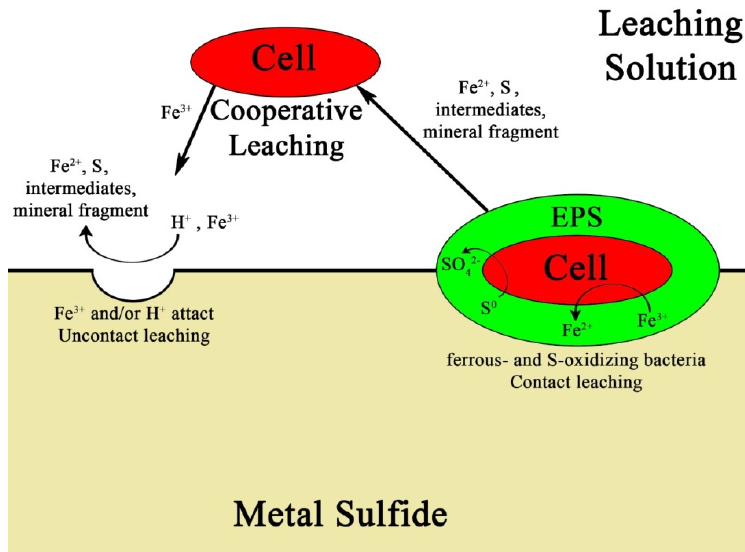
Figure 4. Schematic of the three possible bioleaching mechanisms: the contact, the cooperative, and the un-contact mechanism.